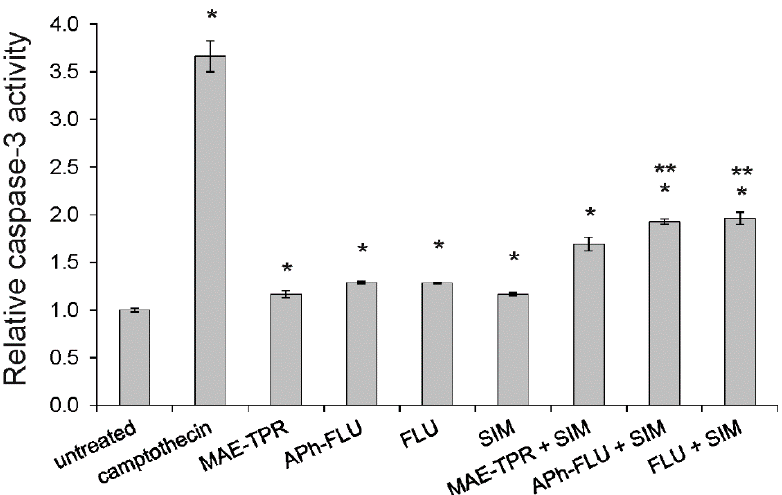
Figure 8. Relative caspase-3 activity in LoVo/Dx cells that were treated with phenothiazine derivatives, simvastatin (SIM), and phenothiazine derivatives in combination with simvastatin. Means of three experiments ± SD are presented. The statistically significant differences from the untreated LoVo/Dx control were determined using Student’s t -test (* p < 0.05). The statistically significant differences between samples containing phenothiazine derivative as a single agent and samples with phenothiazine derivative combined with simvastatin were also determined using the Student’s t -test (** p < 0.05).